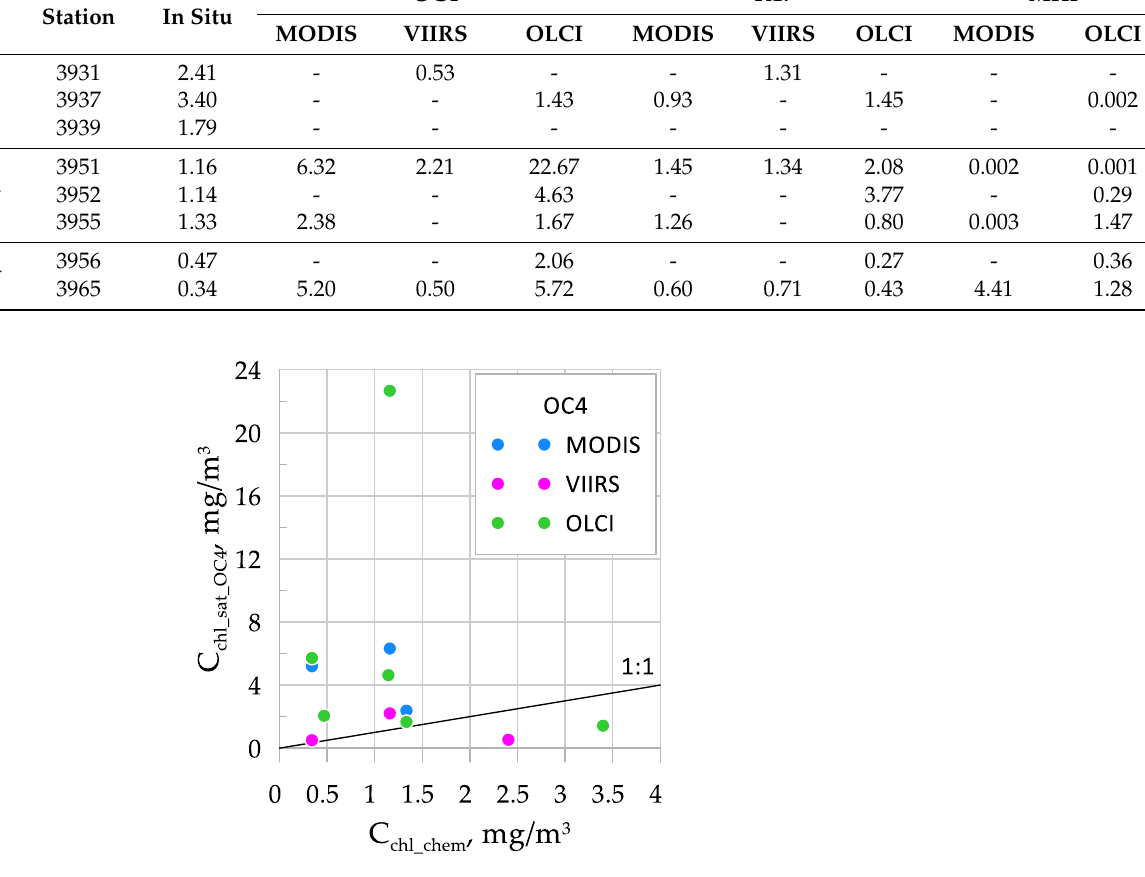
Figure 8. The comparison between measured ( C chl _ chem ) and satellite OC4 chlorophyll-a product from MODIS, VIIRS, and OLCI